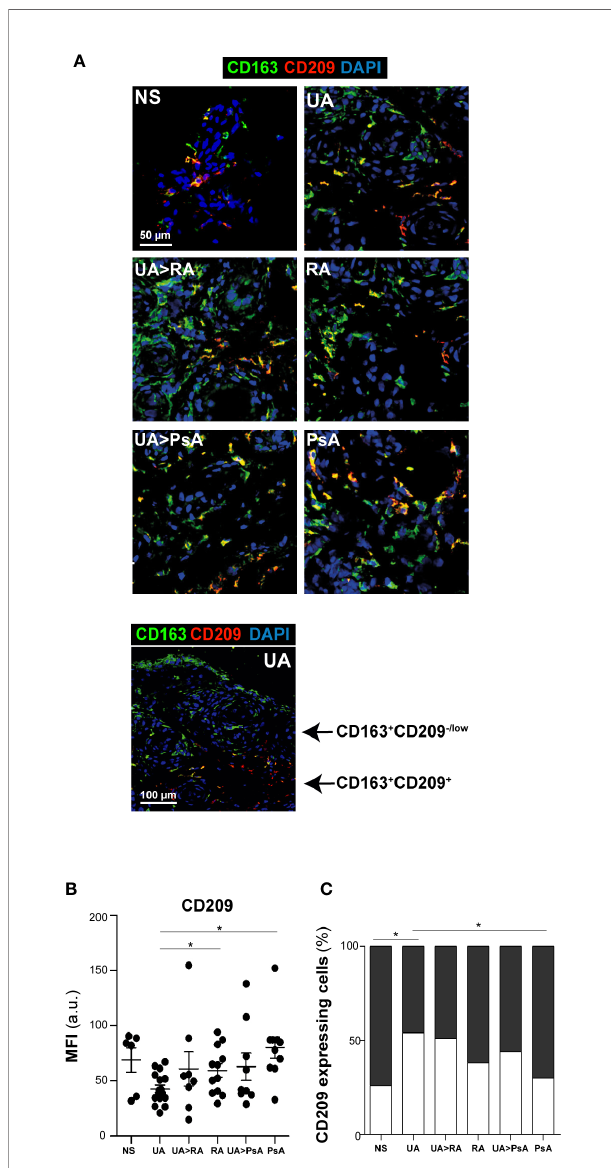
FIGURE 4 | CD163 + CD209 macrophage subsets in synovial tissue. (A) CD163 (green) and CD209 (red) staining of NS, UA, UA-RA, RA, UA-PsA, and PsA synovial tissues. Scale bar, as shown. (B) Summary dot plot showing mean MFI values of CD209 expression in CD163 + macrophages from synovial tissue samples. The experiment was carried out in independent samples from each type (NS, n=6; UA, n=16; UA>RA, n=8; RA, n=12; UA>PsA, n=9; and PsA, n=10) and representative experiments are shown. Mean ± SEM are shown (* p < 0.05, Mann-Whitney test). (C) Percentage of CD209-expressing macrophages in NS, UA, UA>RA, RA, UA>PsA, and PsA synovial tissues. The MFI values of eight to 12 tissues samples of each group were used for classi fi cation as “ low/neg ” (white) or “ high ” (> 34 a.u., black) CD209